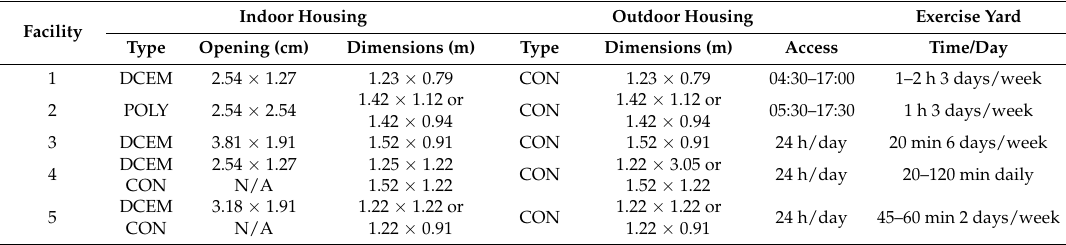
Table 3. Elbow, hock, and paw conditions. Name and description of conditions assessed.